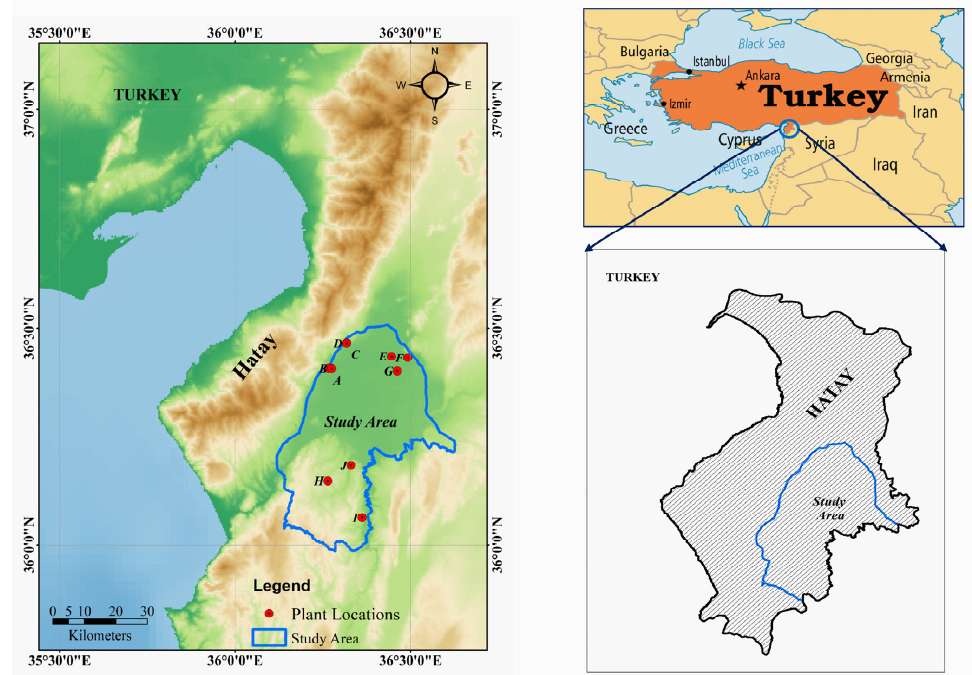
Figure 4. Location map of the study area, which covers an area of 1354 km 2 in the Hatay region of Turkey. The map shows the 10 sampling locations (red dots), and was created using Google Earth Pro and ArcGIS version 10.5.1. (Licensed).